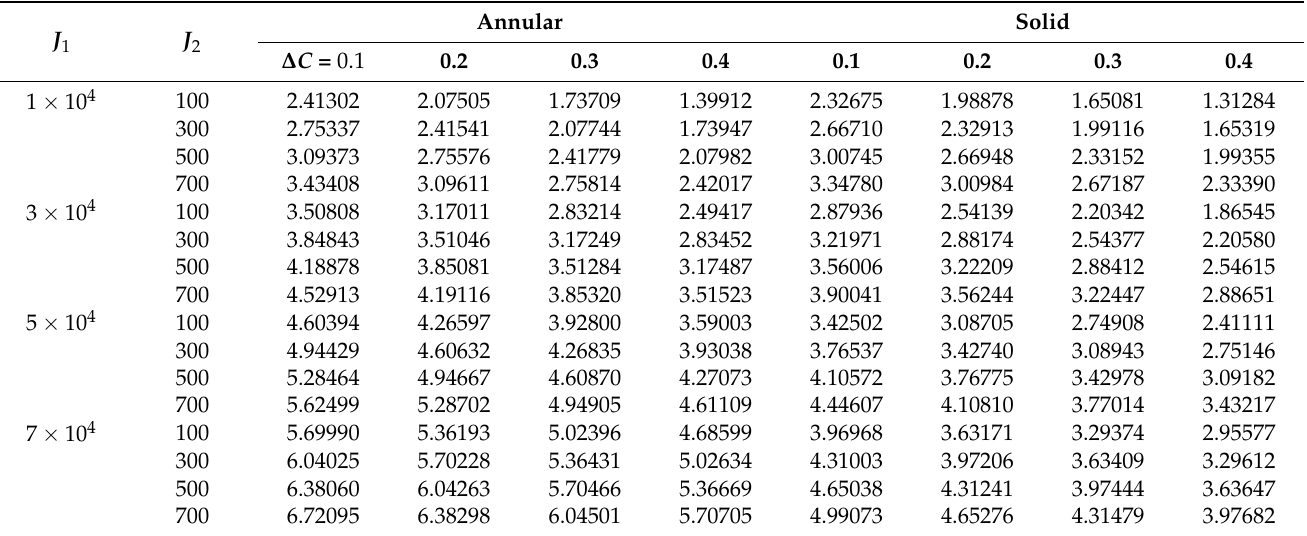
Table 2. Critical buckling temperature ∆ T cr of simply supported SGP annular and solid circular plates for different values of the moisture concentration ∆ C , Winkler coefficient J 1 and Pasternak